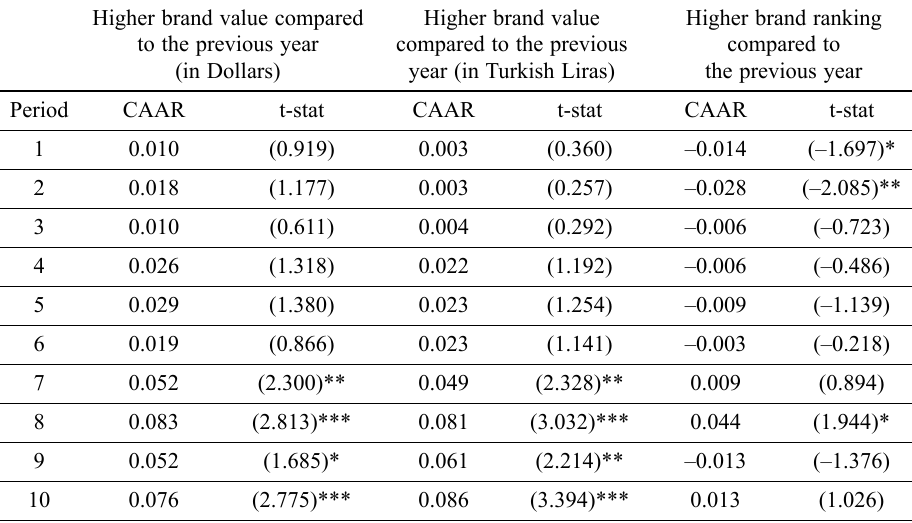
Table 4. Announcement window monthly abnormal returns of the firms with higher brand values or rankings compared to the previous